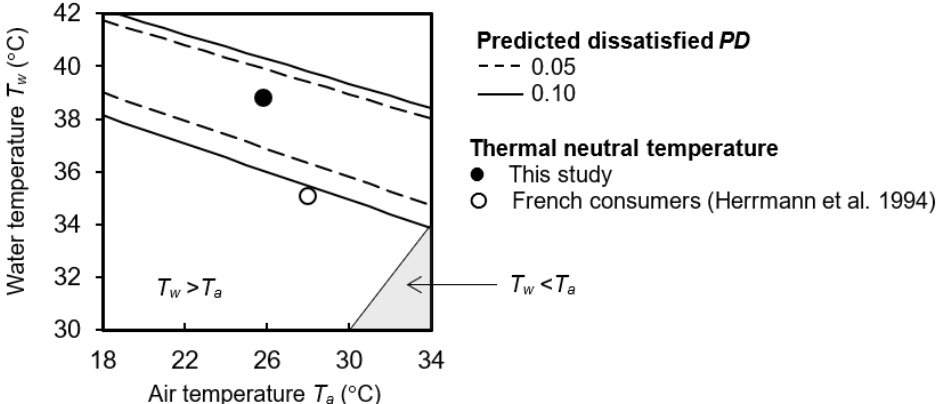
Figure 6. Estimates of predicted dissatisfied PD = 0.05 and PD = 0.10 at thermal neutral T a = 25.8 °C and T w = 38.8 °C; the value reported by Herrmann et. al. [9] is shown for comparison.